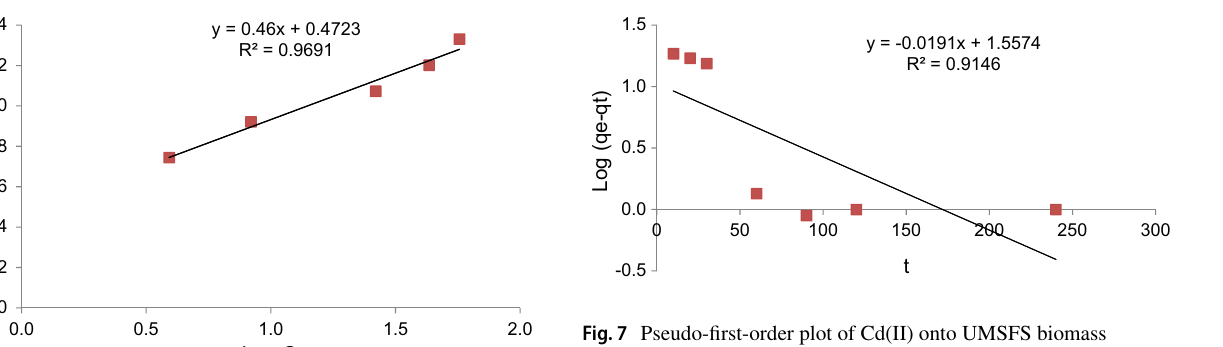
Fig. 7 Pseudo-first-order plot of Cd(II) onto UMSFS biomass